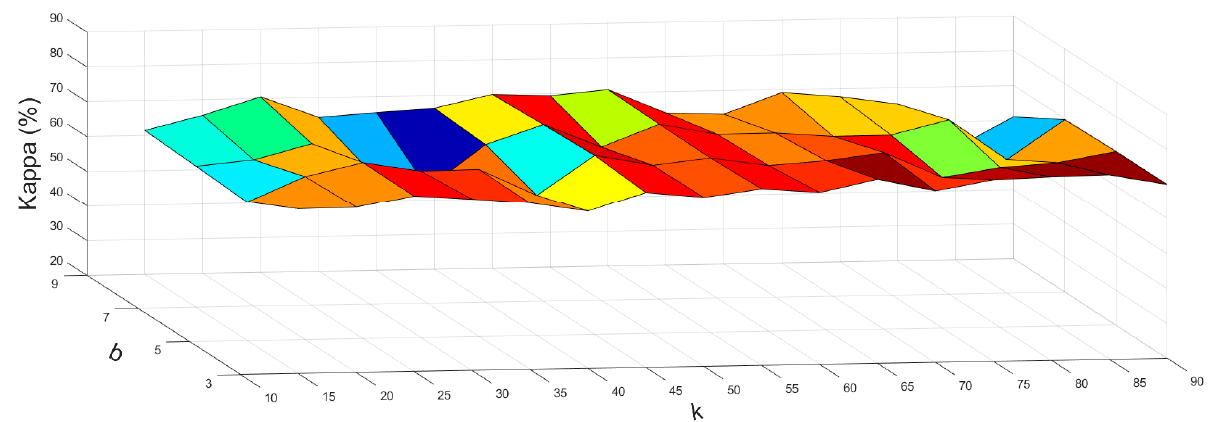
Figure 8. Parameter selection experiment for selecting b and k on the River data set. The results of the USA parameter selection experiment using SCNN-S are shown in Figure 9. Based on the experimental results, we chose a combination of b = 5, k = 80 for our experiments on the USA data set.